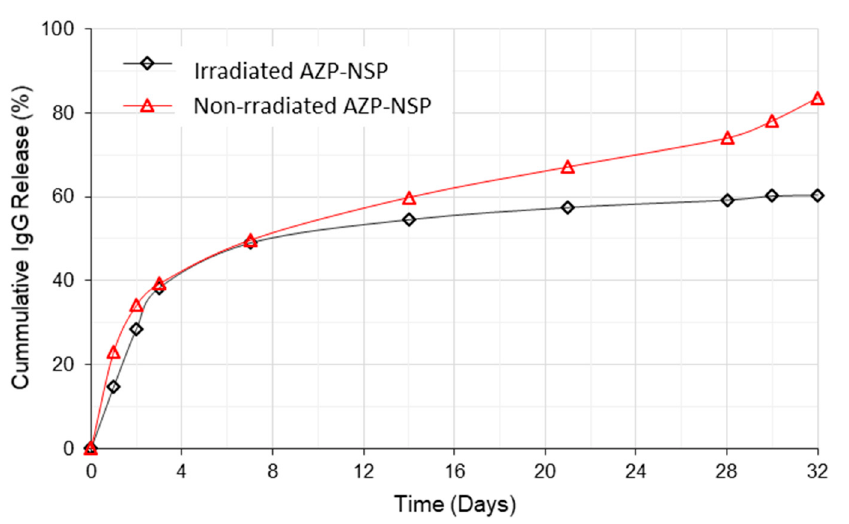
Figure 9. Average diameter of IgG loaded AZP nanospheres upon irradiation with UV light (365 nm) as a function of time.